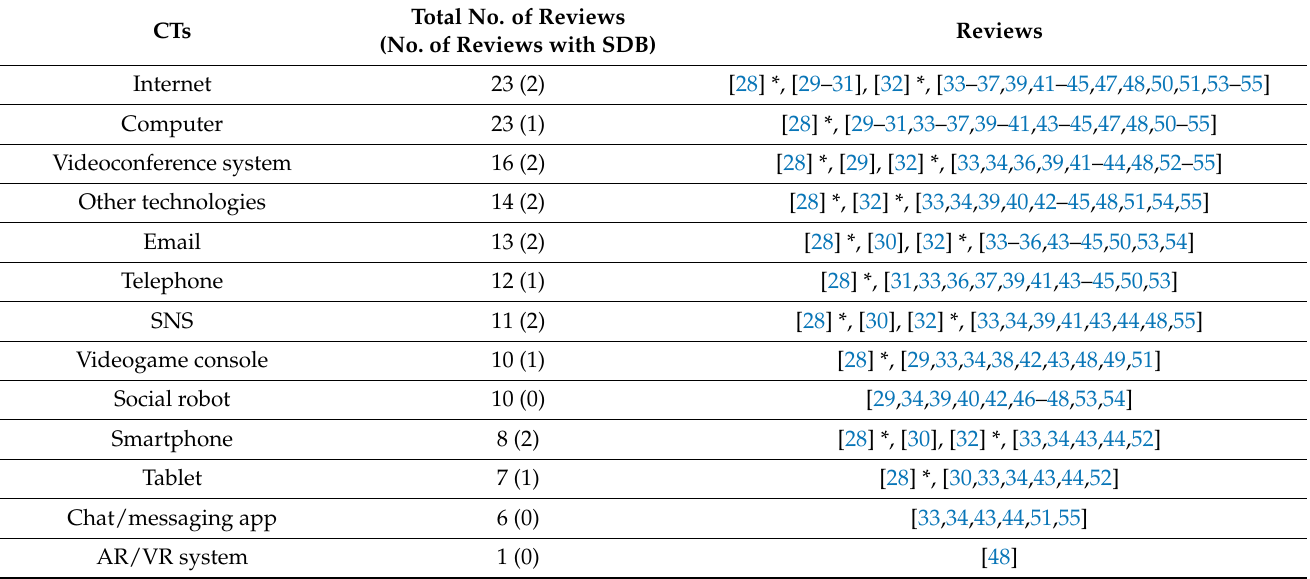
Table 2. Investigated CTs and Context of Use as Represented in the Included Research Reviews (Descending Order of